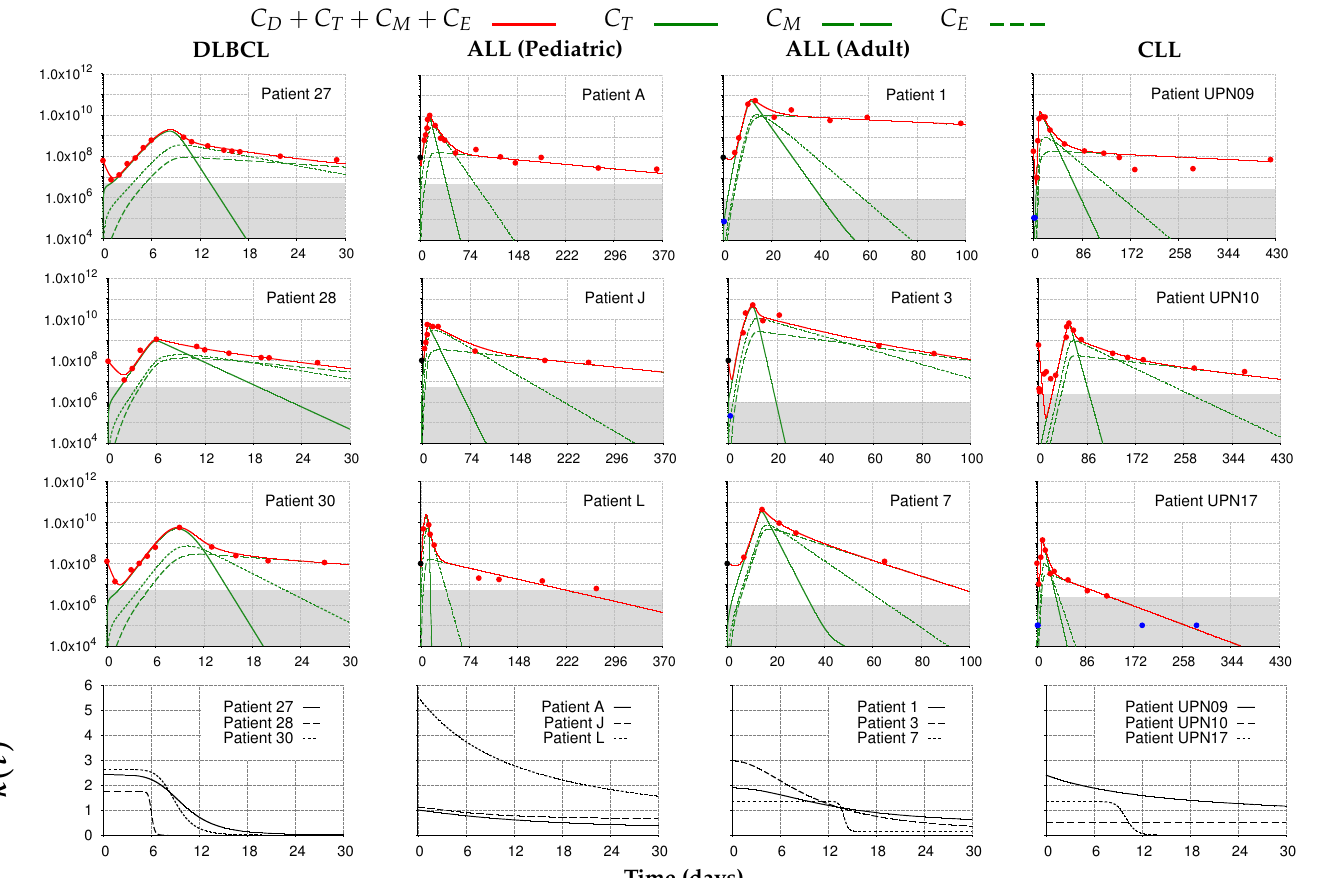
Figure 3. Model simulations fitted to the experimental data ( • ) from [22]. Each column corresponds to the dynamics of the total CAR-T cell population ( ) for different diseases (DLBCL, pediatric and adult ALL, and CLL) and different patients. The total CAR-T cell population is divided into effector ( C T ), memory ( C M ), and exhausted ( C E ) phenotypes, shown in continuous, dashed, and dotted green, respectively. The mean dose value of 1.0 × 10 8 cells ( • ) presented in [21] is used as a surrogate for the actual doses when not reported for patients with ALL. The gray region represents the undetectable levels (below the threshold of 5.0 × 10 6 cells to DLBCL and pediatric ALL, 1.0 × 10 6 cells to adult ALL, and 2.5 × 10 6 cells to CLL [22]). Data points in this region ( • ) were not used for calibration and error calculation due to their high uncertainties. The bottom row presents the time-dependent expansion rate function ( κ ( t ) ) for each